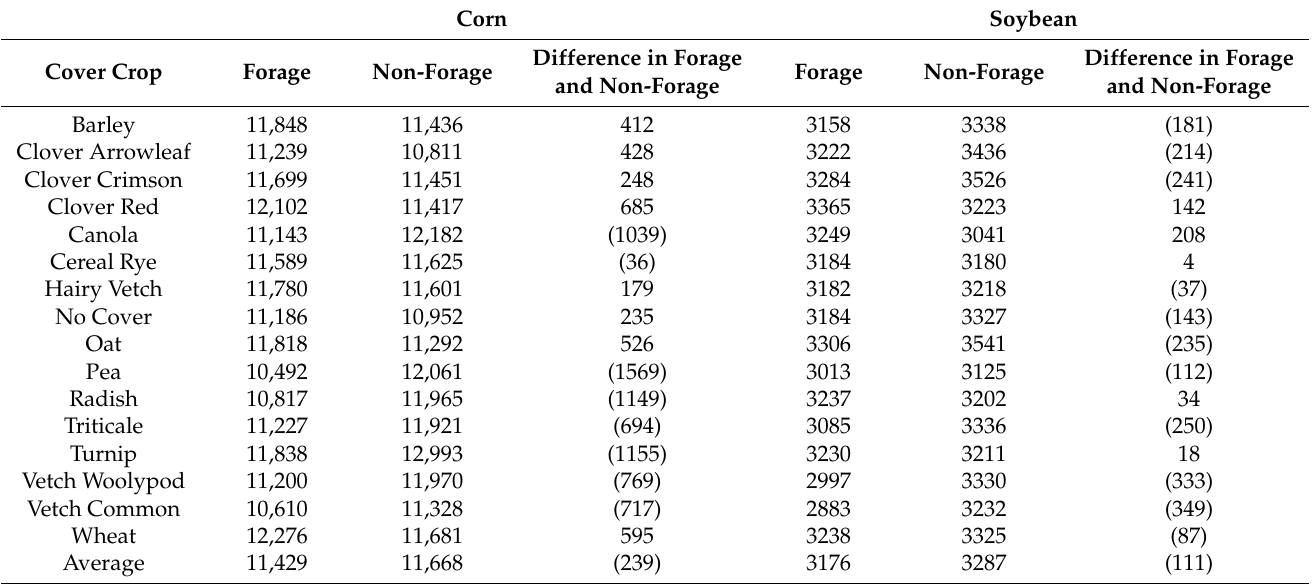
Table 2. Average corn and soybean yield (kg ha − 1 ) for forage and non-forage harvested treatments across years and locations.